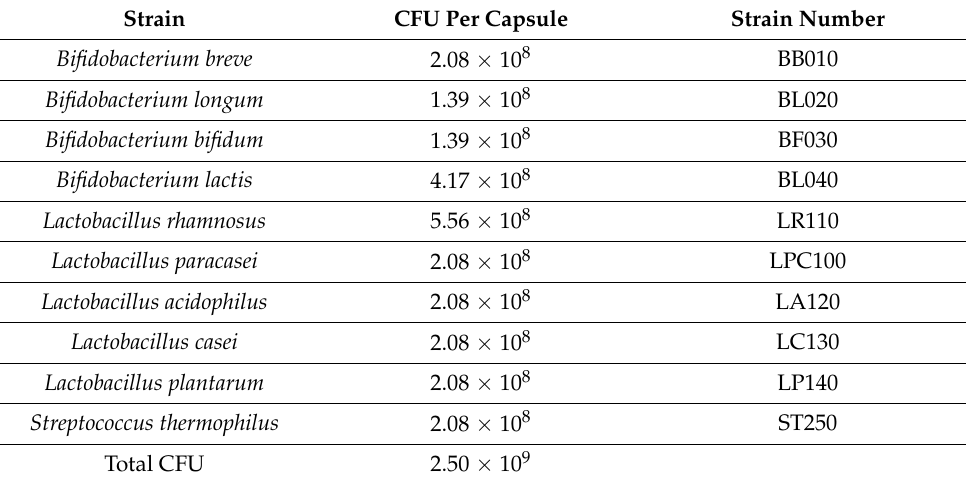
Table 1. Specification of strains (NordBiotic™) used in the evaluated probiotic preparation.